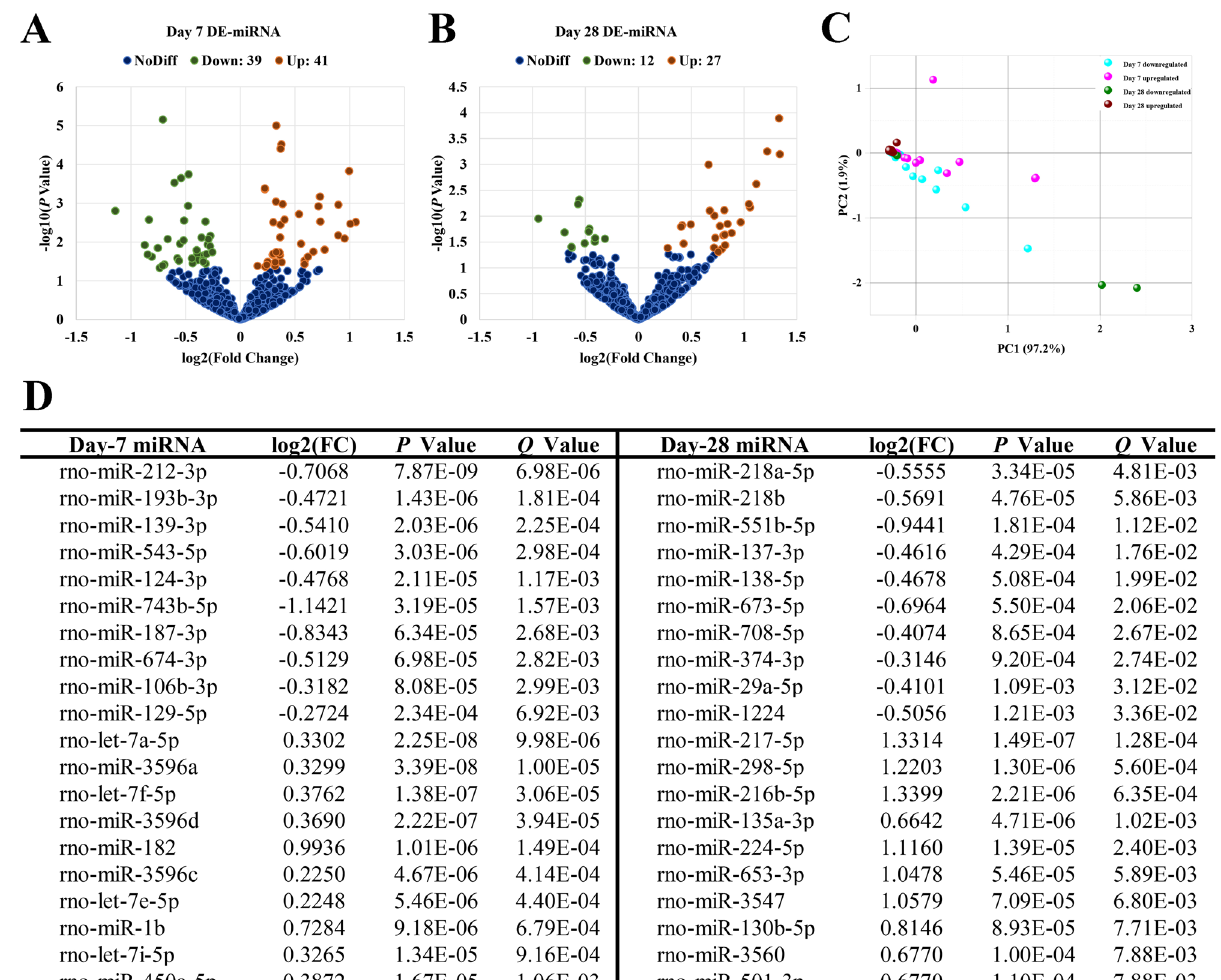
Figure 3. Differences in the miRNA expression profile between Sham and ICH groups. ( A ) Volcano plot showed differential expression of miRNAs between Sham and ICH groups on the 7th day. ( B ) Volcano plot showed differential expression of miRNAs between Sham and ICH groups on the 28th day. ( C ) PCA plot revealed the discrimination between day-7 and day-28 samples. ( D ) Top 10 differentially downregulated and top 10 differentially upregulated miRNAs, in ICH samples, on days 7 and 28, respectively. The horizontal line in the volcano map represented the fold (log 2 scaled) down or up changes; the vertical line represented a corrected P value of 0.05 (-log 10 scaled); green spots indicated the differentially down-expressed RNAs with statistical significance; red spots indicated the differentially up-expressed RNAs with statistical significance; blue spots indicated RNAs with no statistically significant expression. The variances explained by the principal components chosen were shown as PC1 and